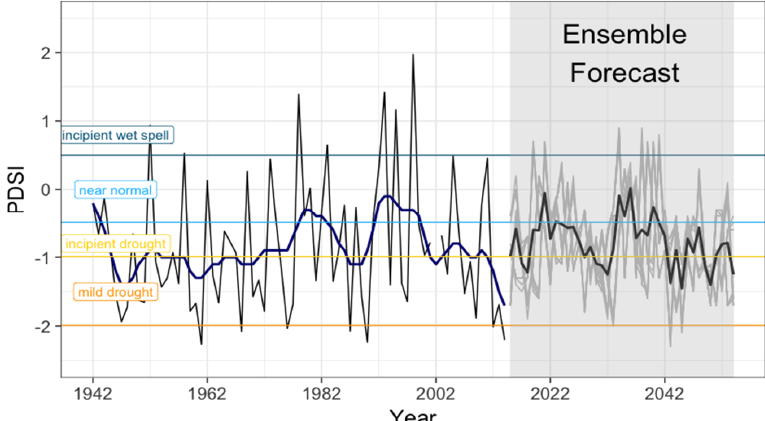
Figure 6. Evolution of observed annual PDSI (black curve) with its smoothed 11-year Gaussian filter in bold blue curve (1942–2014), and exponential smoothing forecasts (2015–2054) with plume prediction (light gray) and the ensemble mean value (bold black line). PDSI classes are also reported.